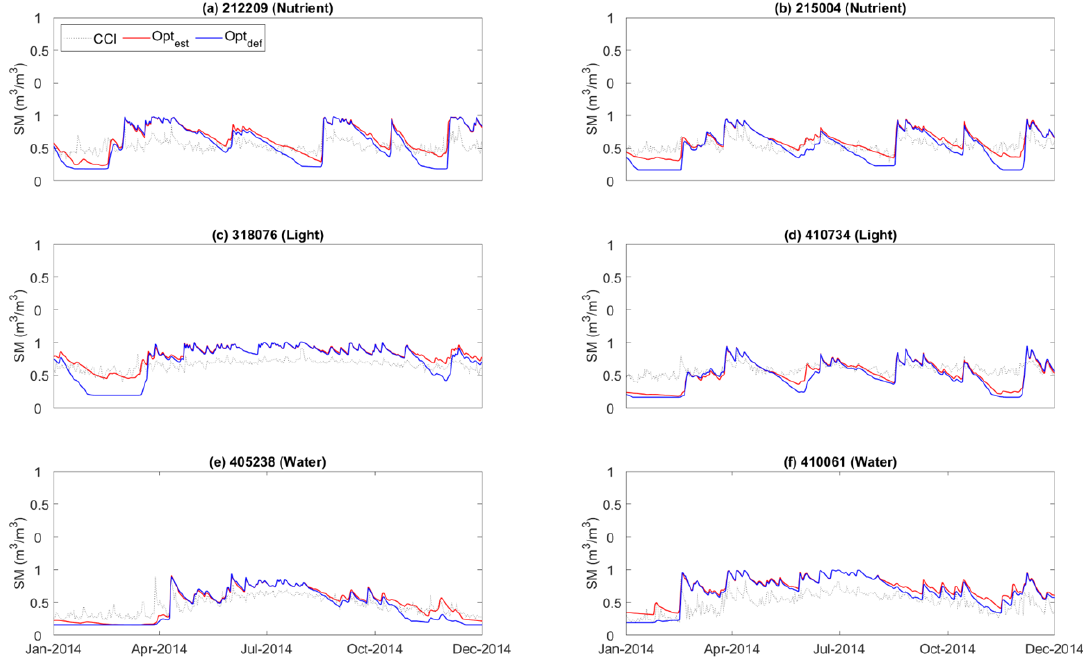
Figure 3. 1-year time series of daily SM derived from CCI SM (black dotted-line) and simulated by Opt (blue continuous line) and Opt (red continuous line) respectively for six selected catchments: ( a ) 212209, ( b ) 215004, ( c ) 318076, ( d ) 410734, ( e ) 405238 and ( f )